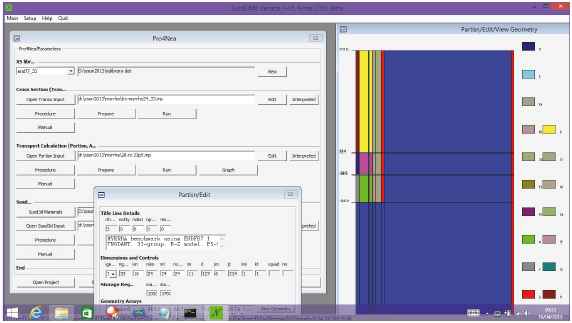
Figure 9: XSUN-2017 computational running segment with the view of the MYRRHA geometry modeling.